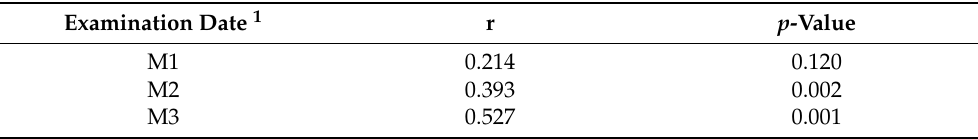
Table 4. Correlation coefficients (r) and p -values of the Ortolani test with the reduction angle at three examination times. Table 5. Correlation coefficients (r) and p -values between the reduction angle and results of the F é d é ration Cynologique Internationale (FCI) scoring